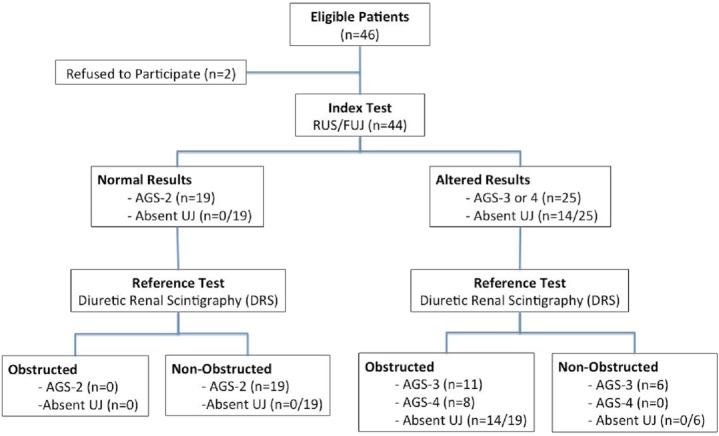
Flowchart of study design and test results.